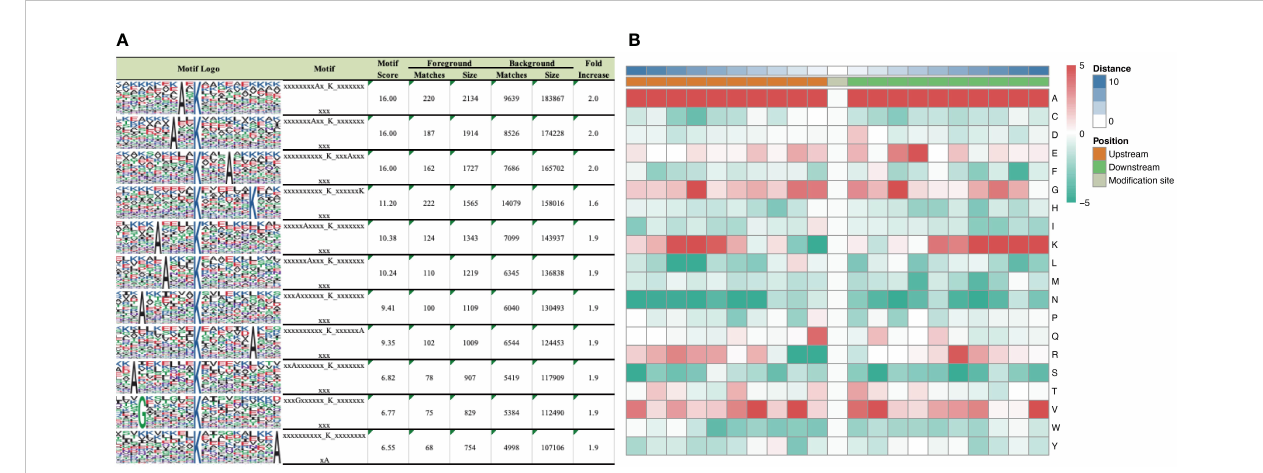
FIGURE 3 Motif analysis of differentially expressed succinaylated sites. (A) Succinaylated sites in particular positions (10 amino acids close to two sides of the succinaylated sites), analyzed using motif-X software. (B) Heatmap showing the periodicity of the diverse types of amino acids near the succinylated